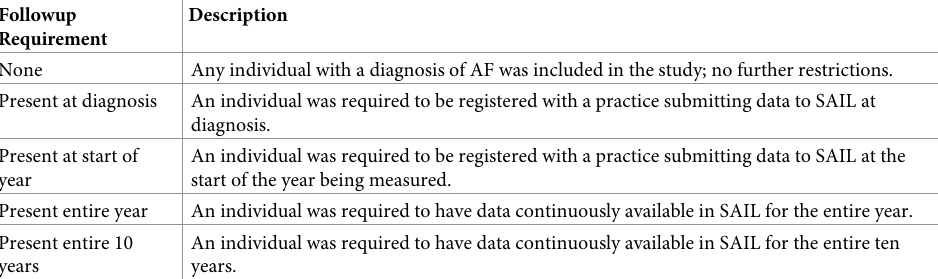
Table 2. Overview of different follow-up requirements in example